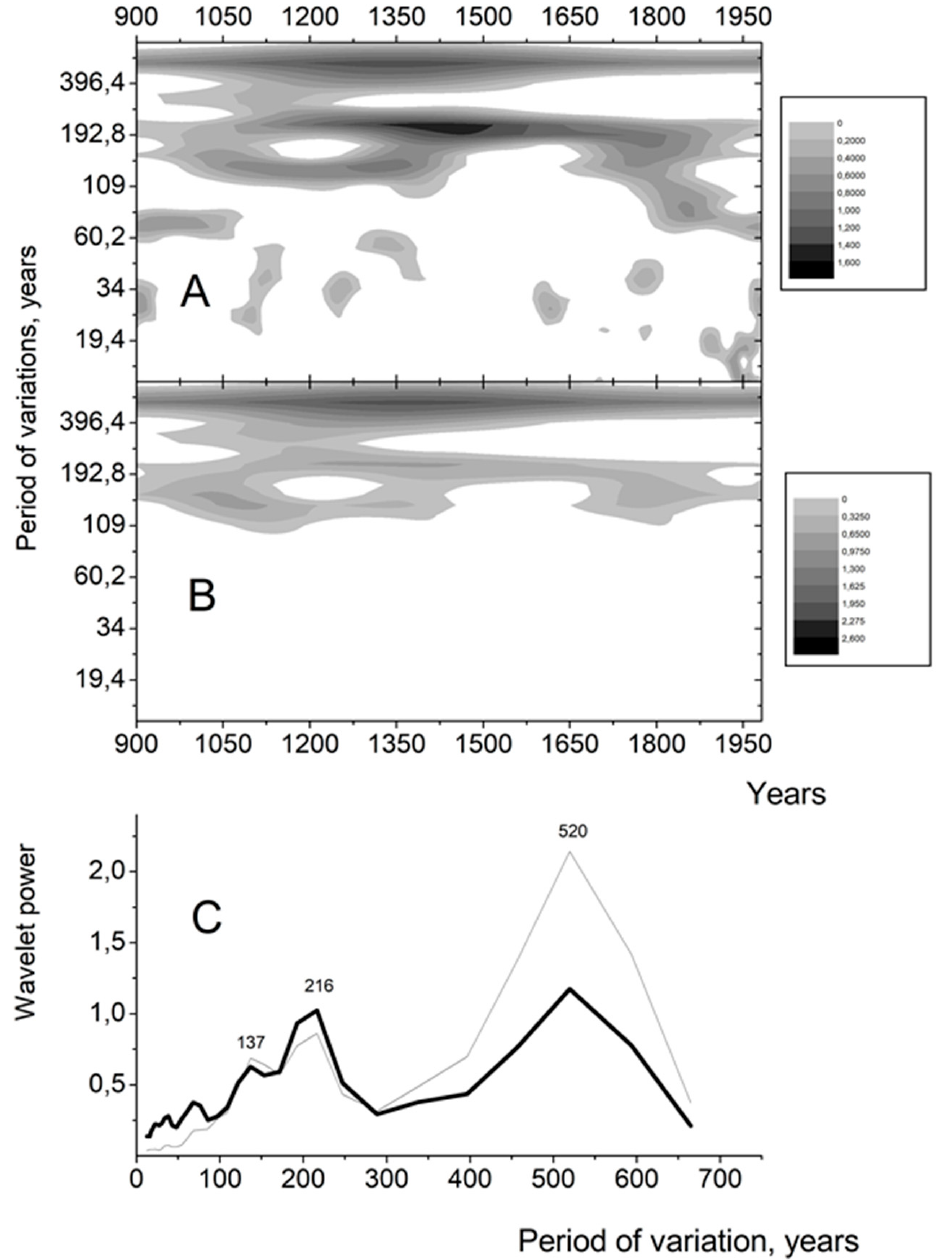
Figure 3. ( A )—Local cross-wavelet power spectrum of temperature in SSA [10] and Φ [12]; ( B )—local cross-wavelet power spectrum of temperature in SSA [10] and TSI [11]; ( C )—global cross-wavelet spectra of temperature in SSA and Φ (thin gray line) and TSI (thick black line). The spectra are normalized to 0.95 confidence level calculated for red noises with the corresponding AR(1) coefficient. Although the synchronism of multi-centennial oscillations in solar activity and climate looks convincing, it is premature to draw conclusions based on just two